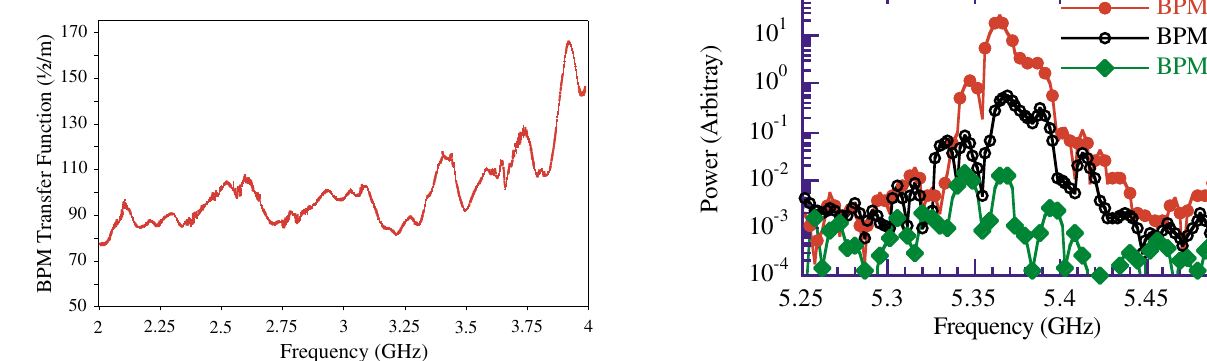
FIG. 10. (Color) Response function of a BPM.